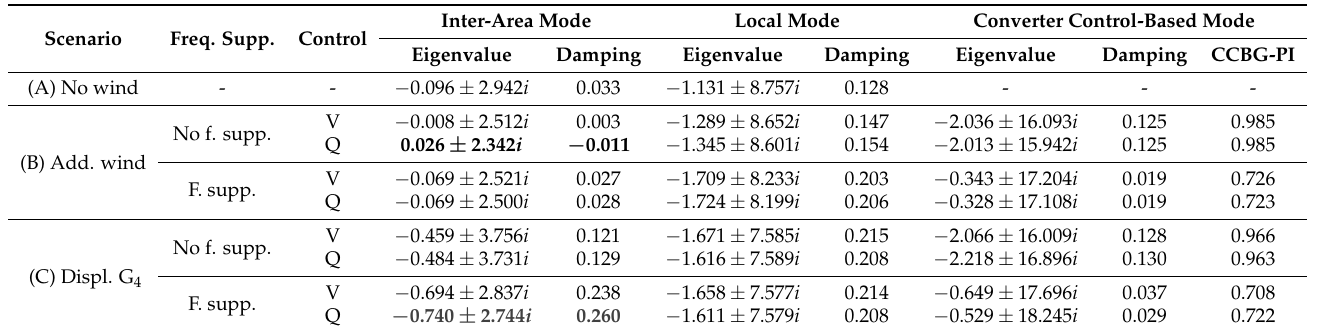
Table 3. Result summary for all scenarios considering dominant inter-area, local and converter control-based modes. The bold and dark gray values highlight the unstable and the most stable case,